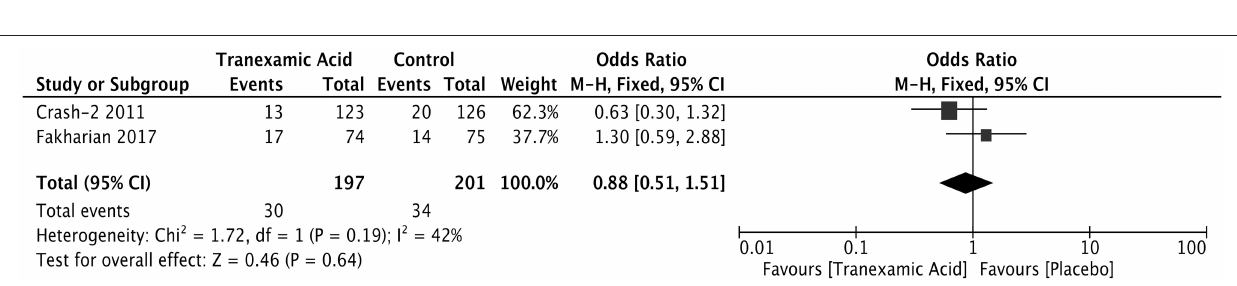
FIGURE 7 | Forest plot of the comparison between tranexamic acid and placebo treatments for new